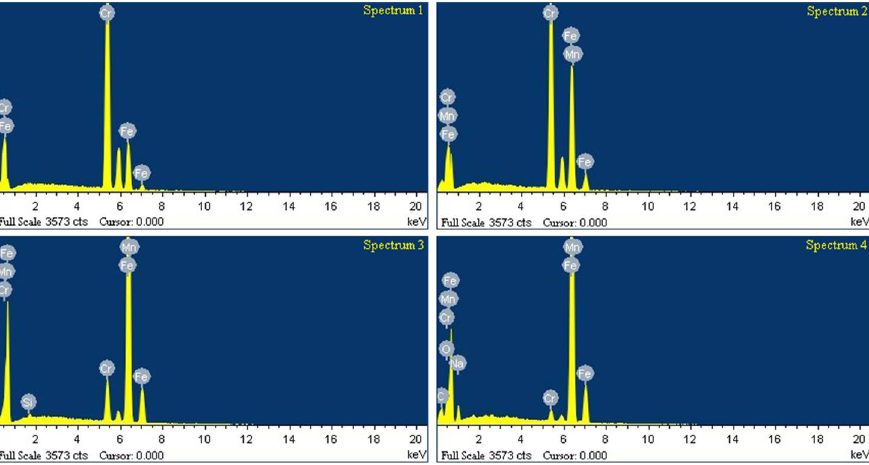
Figure 3. Electron probe microanalysis of chromium carbide and chromium plating coatings. ( a ) Chromium carbide coating; ( b ) Chromium plating coating.